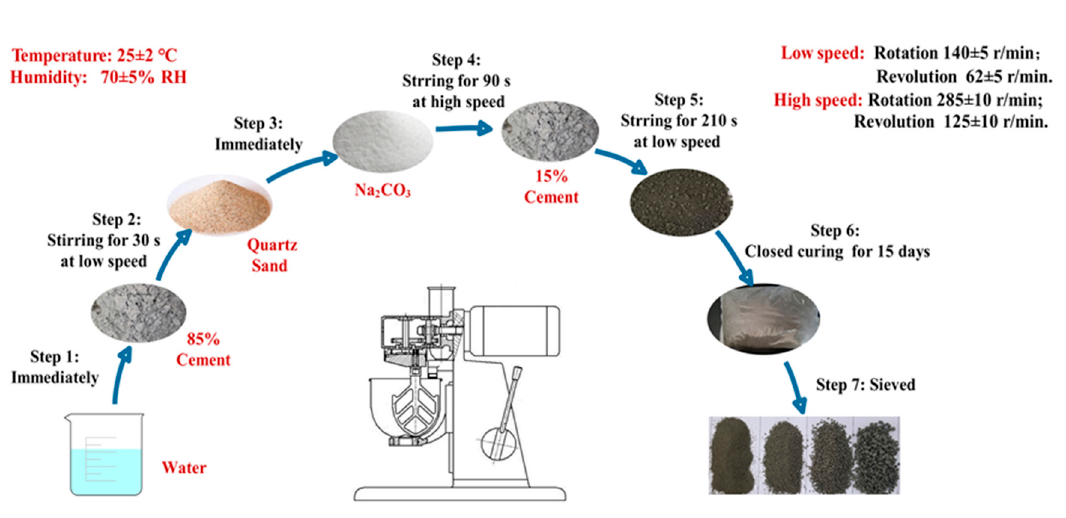
Figure 2. Pelletization process of CHPs.